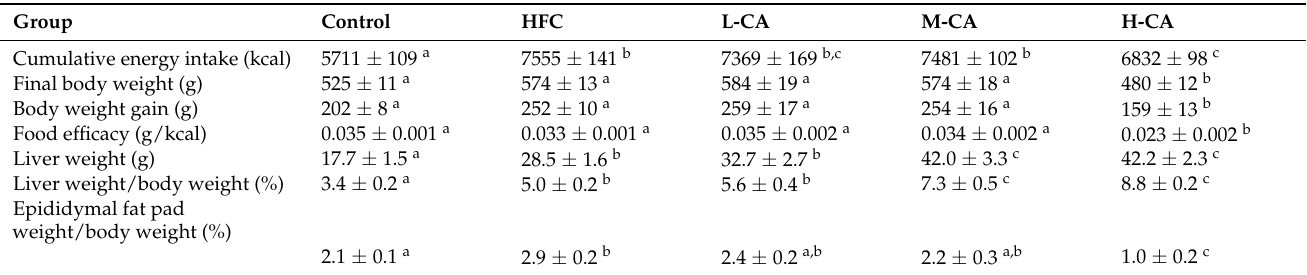
Table 1. Cumulative energy intake, body weight, and relative organ weights in Sprague–Dawley rats fed the normal, HFC and CA-supplemented HFC diet for 9 weeks.